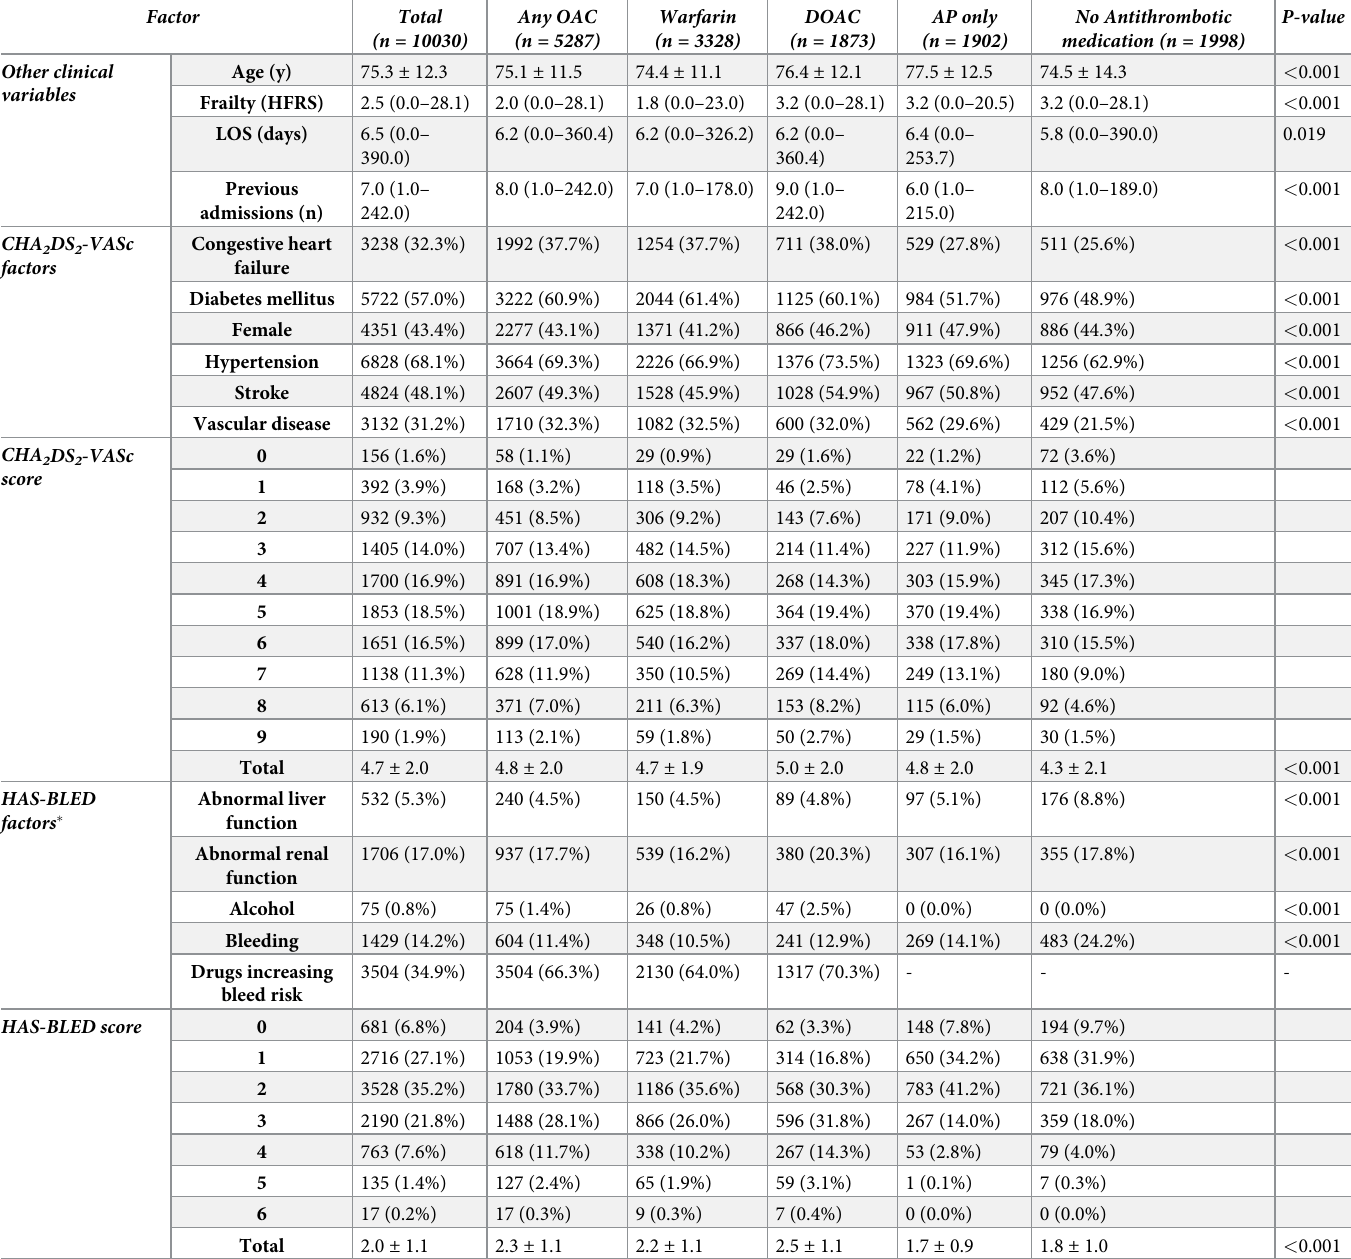
Table 1. Baseline characteristics of study